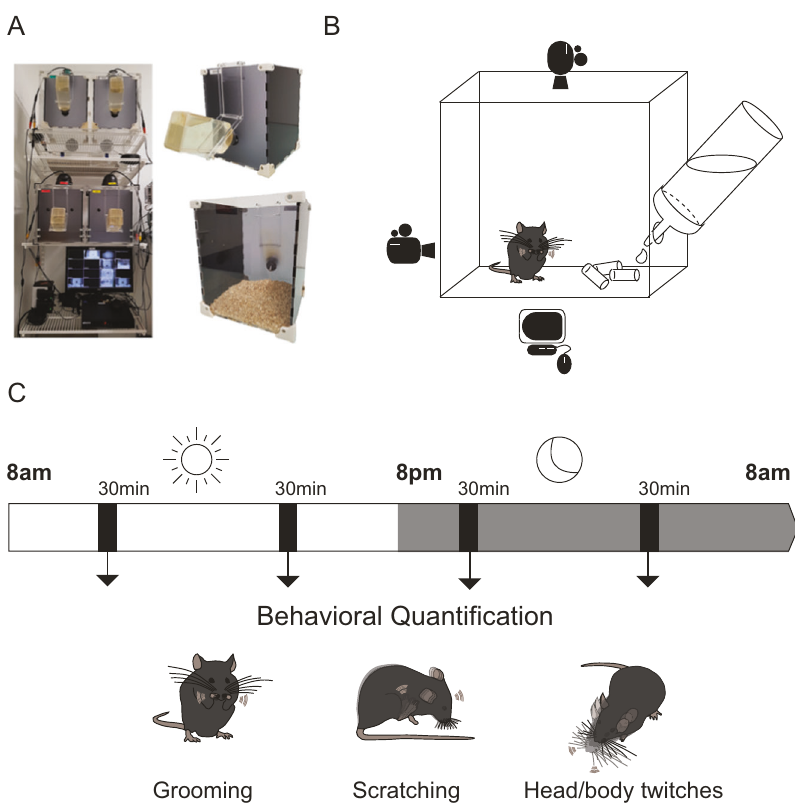
Fig. 1 Behavioural assessment of Sapap3 − / − mice. A Photographs of custom-made apparatus for behavioural assessment, consisting of four acrylic chambers, each equipped with top and side cameras, connected to a digital video-recording system. B Detailed graphic illustration of a single video chamber with ad libitum water and food access. C Time scale of behavioural assessment. Mice were video-recorded in the behavioural apparatus for 24 h. Four intermittent time bins of 30 min each (i.e., a total of 2 h) were manually analysed of fl ine for repetitive behaviours including self-grooming, head-body twitches and hindpaw scratching. The scored time bins were distributed regularly across the light/dark circadian following previous protocols (Welch et al.,